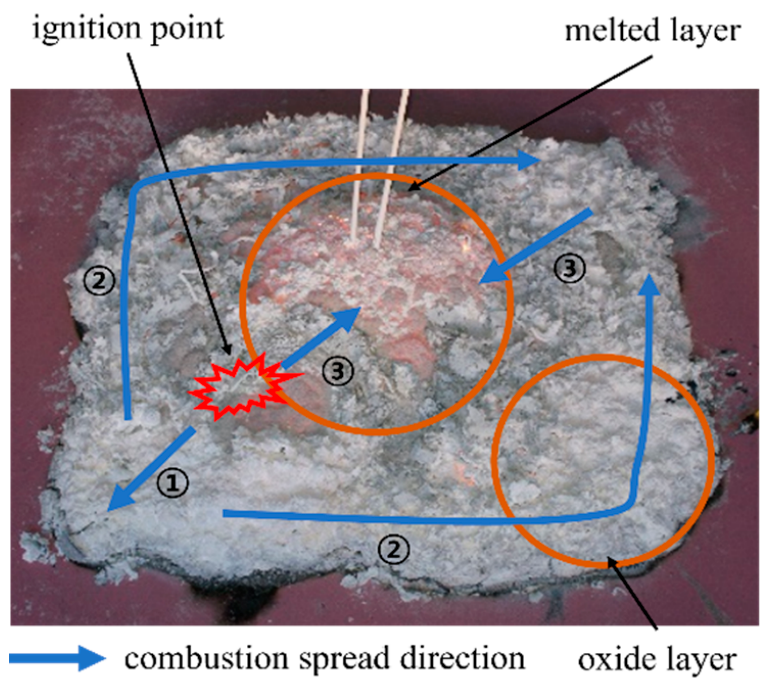
Figure 13. Detected temperature distribution of burning magnesium powder in 720 s. The combustion by-products of magnesium powder created fragile white solid objects on the surface, that is MgO, and coagulated grey objects under the burned surface, as shown in Figure 14. This coagulation is considered as one of the melting phenomena that transfer heat from the inside surface during the burning of magnesium.